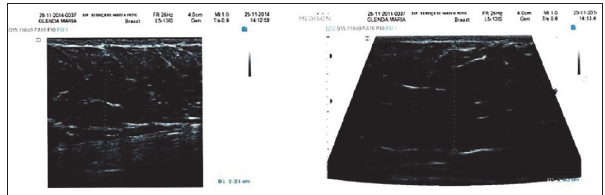
Figure 6: Sonography, 30 days after treatment.